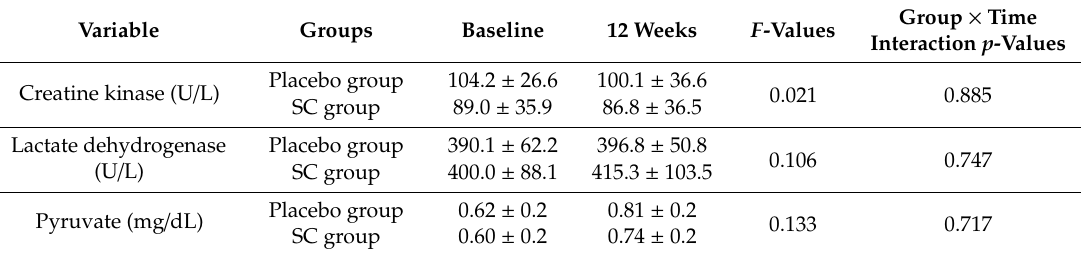
Table 3. Comparisons of blood variables at baseline and 12 weeks, after age adjustment.